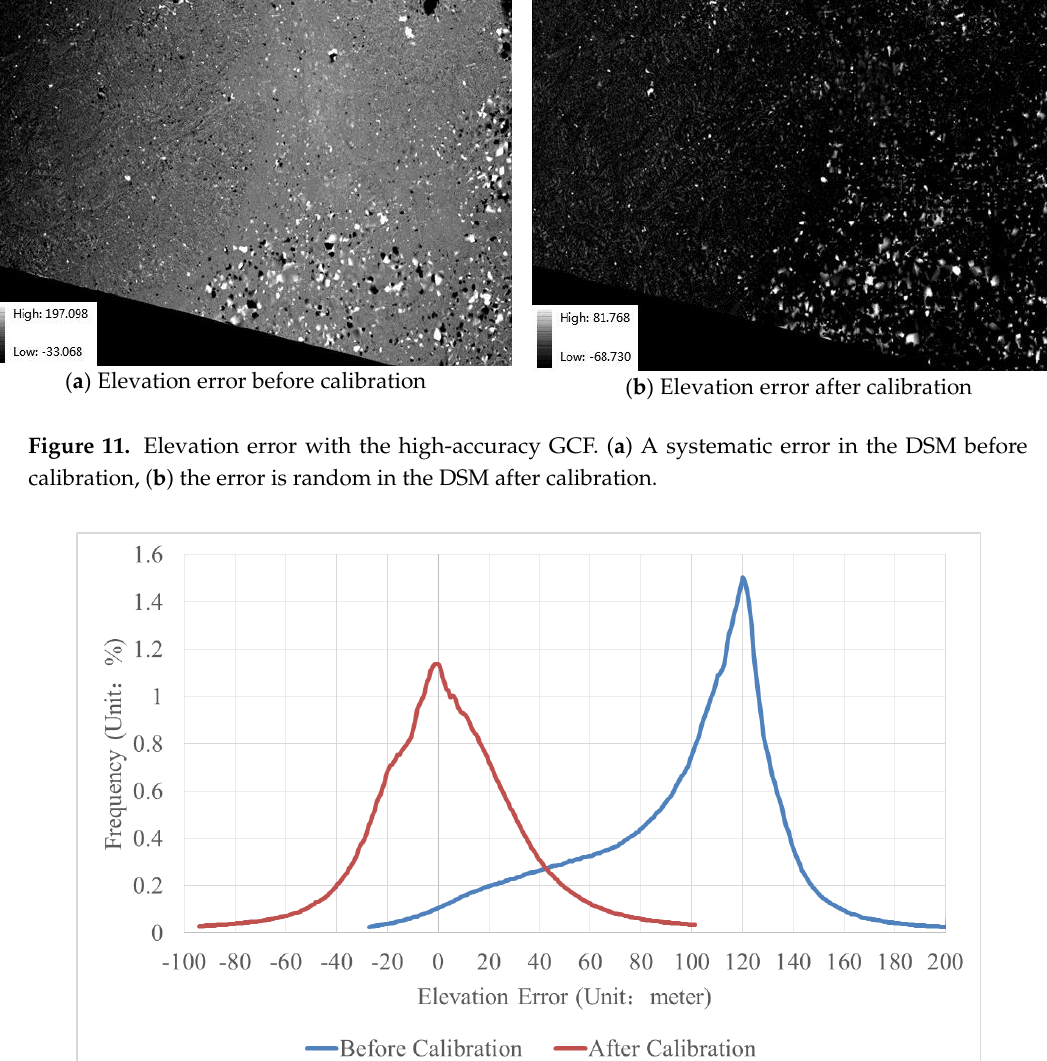
Figure 12. Statistical plot of the elevation error. The peaks are at 120 m and 0 m respectively, before and after calibration. Statistical plot tends to a more standard normal distribution after calibration. Table 6. Elevation error statistics before and after calibration (units: meter). The elevation accuracy can improve from 103 m to 30